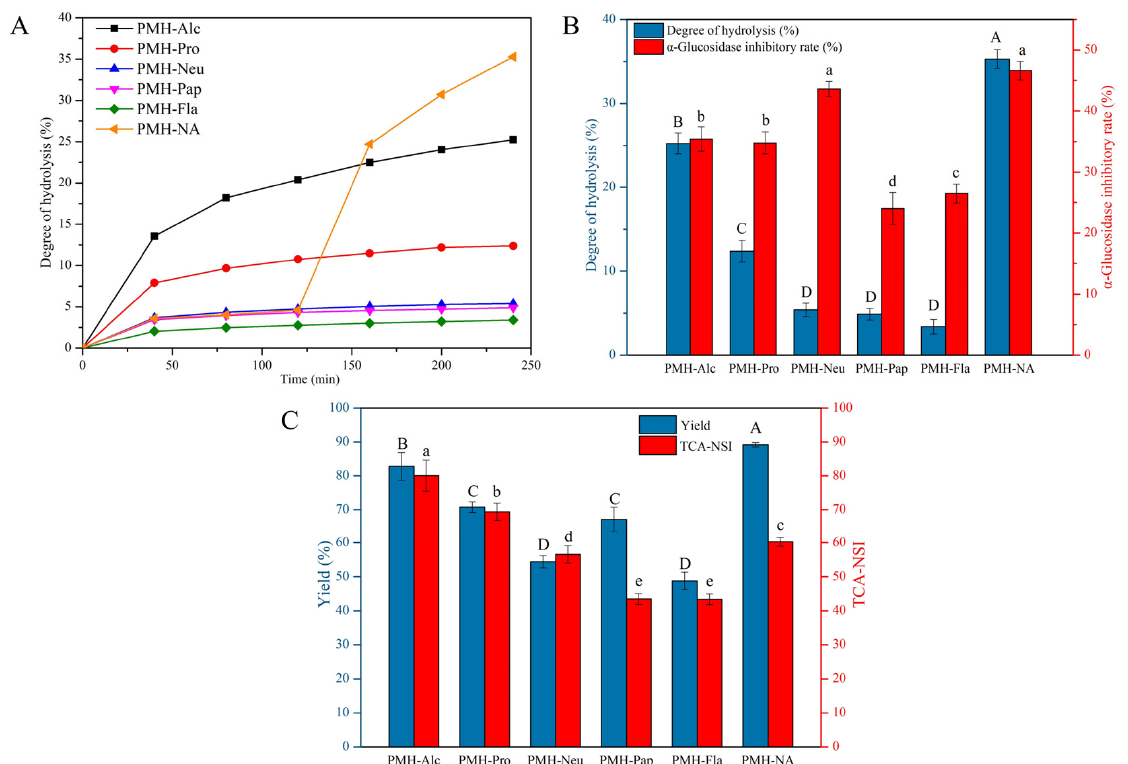
Figure 1. ( A ) Degree of hydrolysis during the hydrolysis of different hydrolysates. ( B ) Nitrogen solubility index and protein yield of different hydrolysates. ( C ) Comparison of degree of hydrolysis and α -glucosidase inhibition rate of different hydrolysates. Different letters indicate significant differences ( p < 0.05).